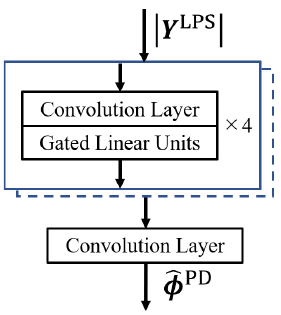
Figure 5. Structure of DNN for phase spectrum